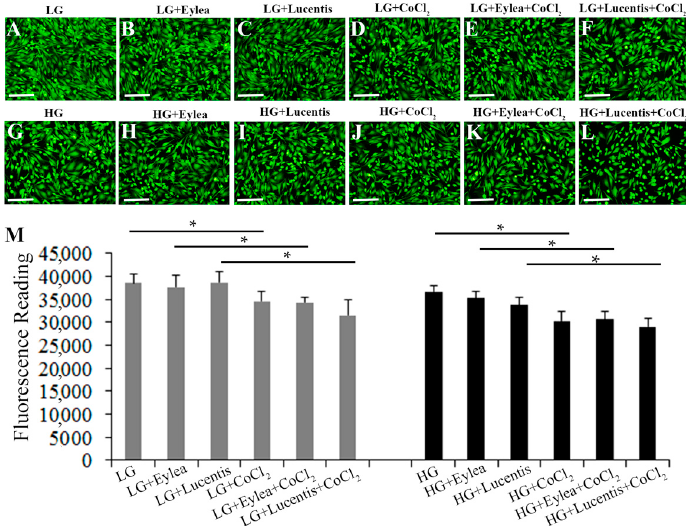
Figure 3. Aflibercept (Eylea, 0.5 mg/mL) and ranibizumab (Lucentis, 0.125 mg/mL) did not affect Müller cell survival under stress conditions. ( A – L ) Fluorescence images of calcein-AM-stained Müller cells exposed to stress media for 24 h. Scale bars: 50 µm; ( M ) Quantitative analysis of Müller cell viability by measuring fluorescence intensity after staining Müller cells with calcein-AM. * p < 0.05, n = 6/group.